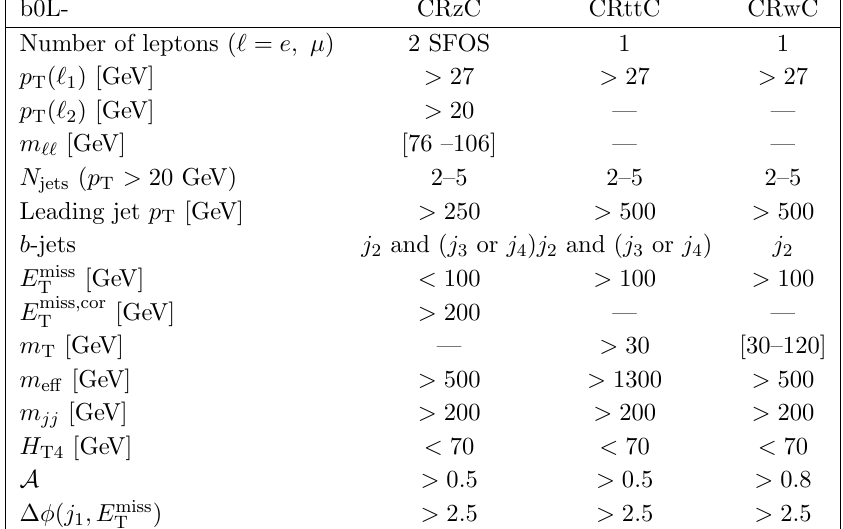
Table 4. Summary of the event selection in each control region corresponding to b0L-SRC. The term lepton is used in the table to refer to signal electrons and muons. Jets ( j 1 , j 2 , j 3 and j 4 ) and leptons ( ‘ 1 and ‘ 2 ) are labelled with an index corresponding to their decreasing order in p T